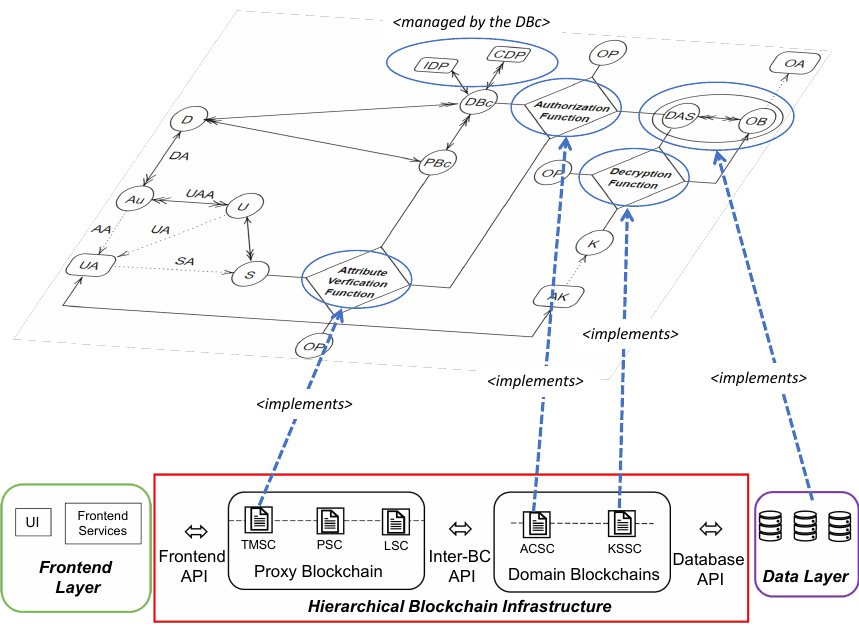
Figure 4. The proposed HMBAC architecture with the HMBAC model of Figure